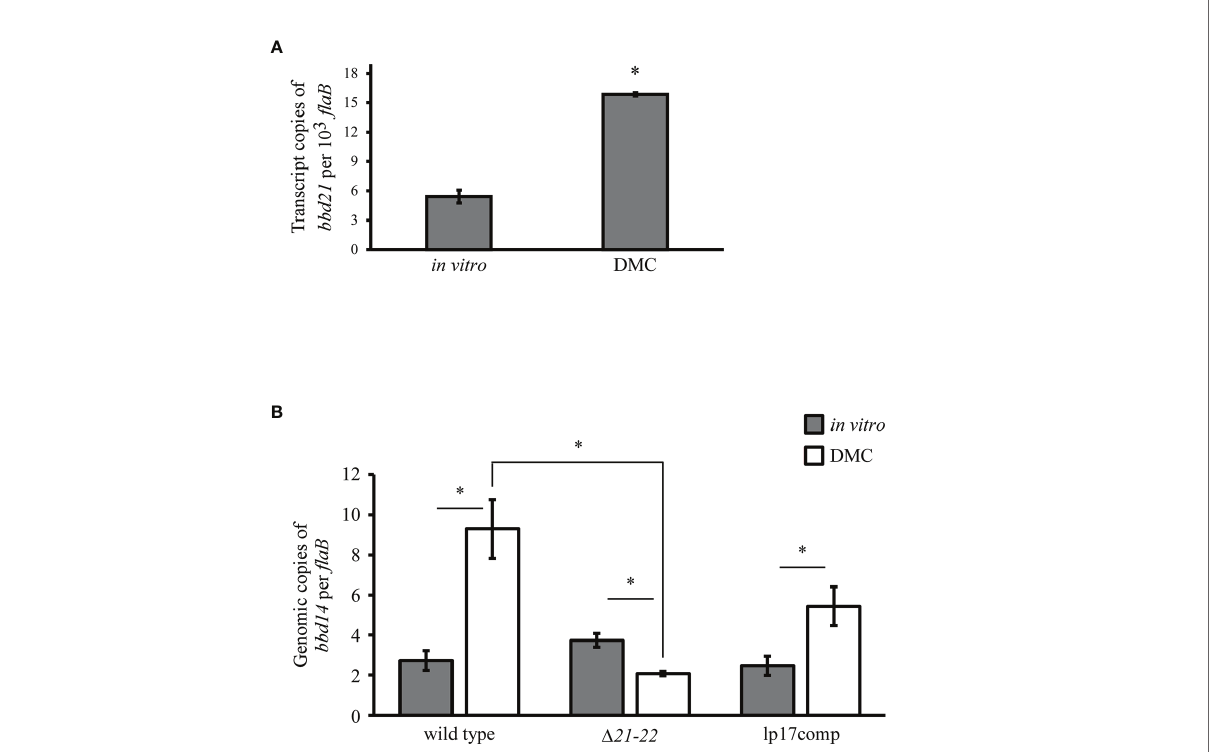
FIGURE 4 | bbd21 transcription and lp17 copy number are expressed differently in DMC-cultivated vs. in vitro -cultivated spirochetes. Mammalian host-adapted spirochetes were generated in dialysis membrane chambers (DMCs) implanted into the peritoneal cavity of rats. (A) qRT-PCR analysis of bbd21 expression in in vitro - vs. DMC-cultivated wild type spirochetes. Bars represent the mean values of three independent experiments, and error bars represent standard error mean. *p<0.05 (Student ’ s t -test). (B) qPCR analyses of lp17 copy number in wild-type, D 21-22 , and lp17comp strains. In vitro conditions are depicted as gray bars, and DMC conditions are depicted as white bars. The bars represent the mean values of three independent experiments, except in the D 21-22 DMC-cultivated spirochetes in which one animal died during surgery (n=2). The error bars represent standard error mean. *p<0.05 (Student ’ s t